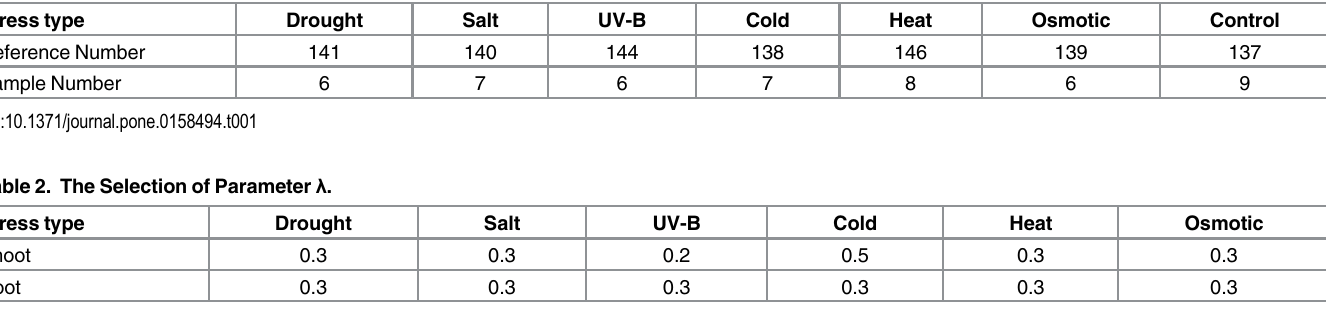
Table 1. Reference and Sample Numbers for Stress Types. Stress type